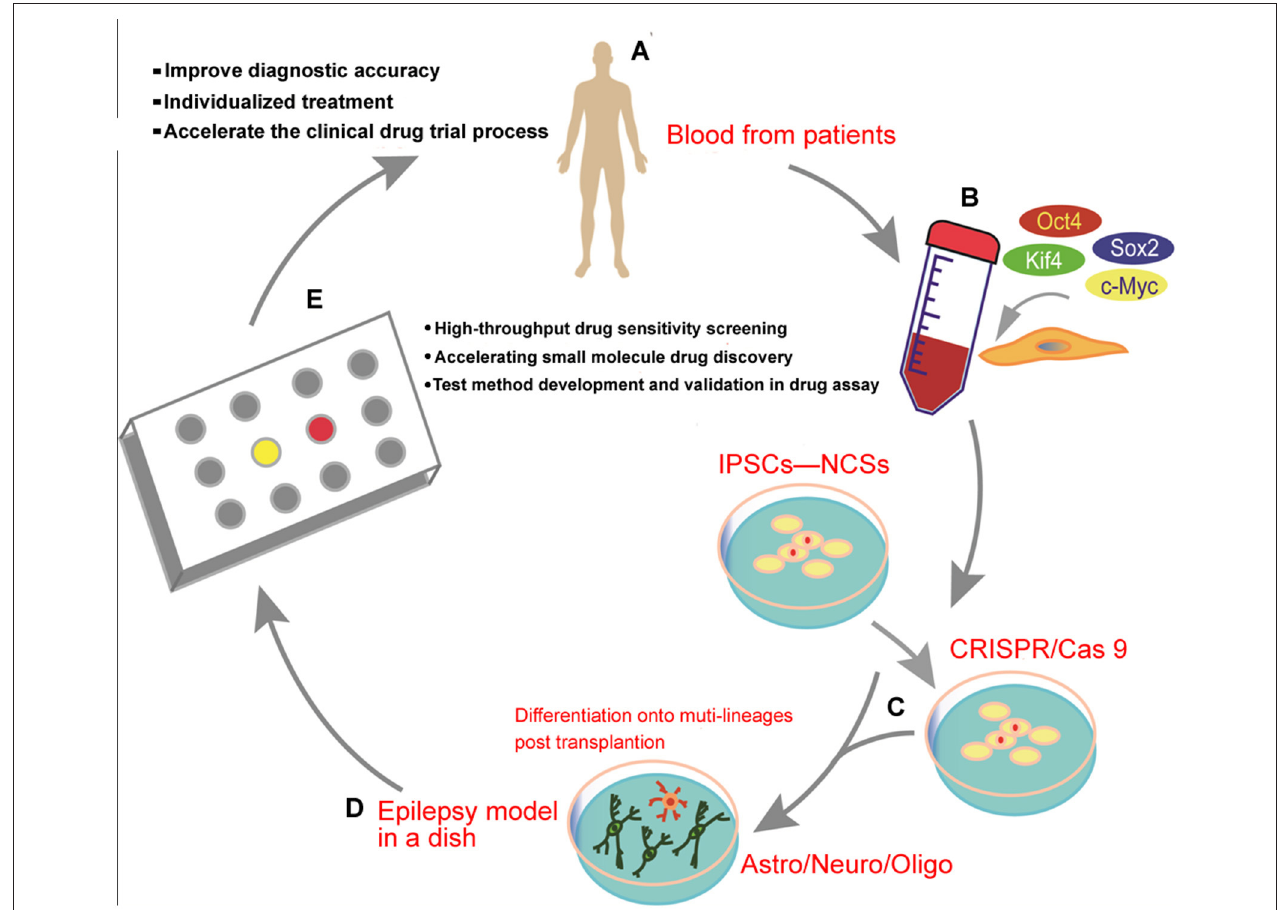
FIGURE 2 | Schematic diagram illustrating the transformation of human-induced pluripotent stem cells (iPSCs) from the clinical trial in a dish to precision medicine for epilepsy: (A) clinical patient recruitment, (B) generation of human iPSCs from the blood of the patients, (C) gene targeting can be effectively achieved using the CRISPR/Cas9 editing system, (D) in vitro generation of human iPSC-derived brain organoids from a mixed population of neurons and glial cells, and (E) drug discovery, individualized therapy, or a clinical trial using the epilepsy-in-a-dish